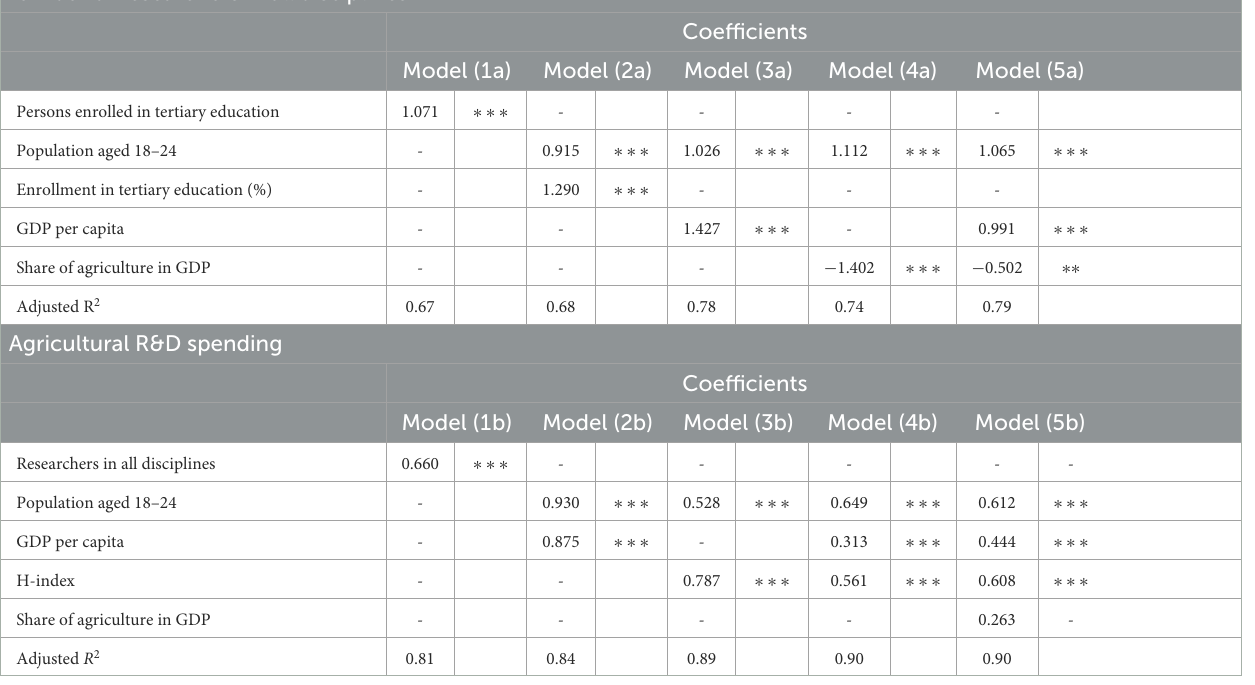
TABLE 5 Coefficients and R 2 obtained from regressing the log of the number of researchers in R&D in all disciplines and agricultural R&D spending against the log of different explanatory variables, average values 2011–2016. Number of researchers in all